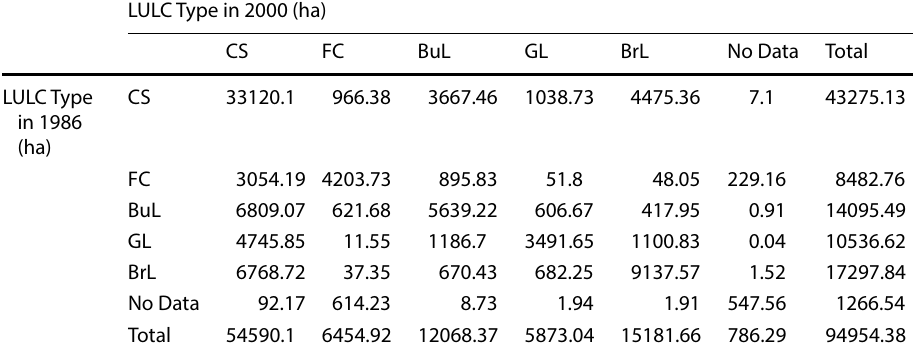
Table 8 LULC conversion matrix of the Gubalafto District between 1986 and 2000